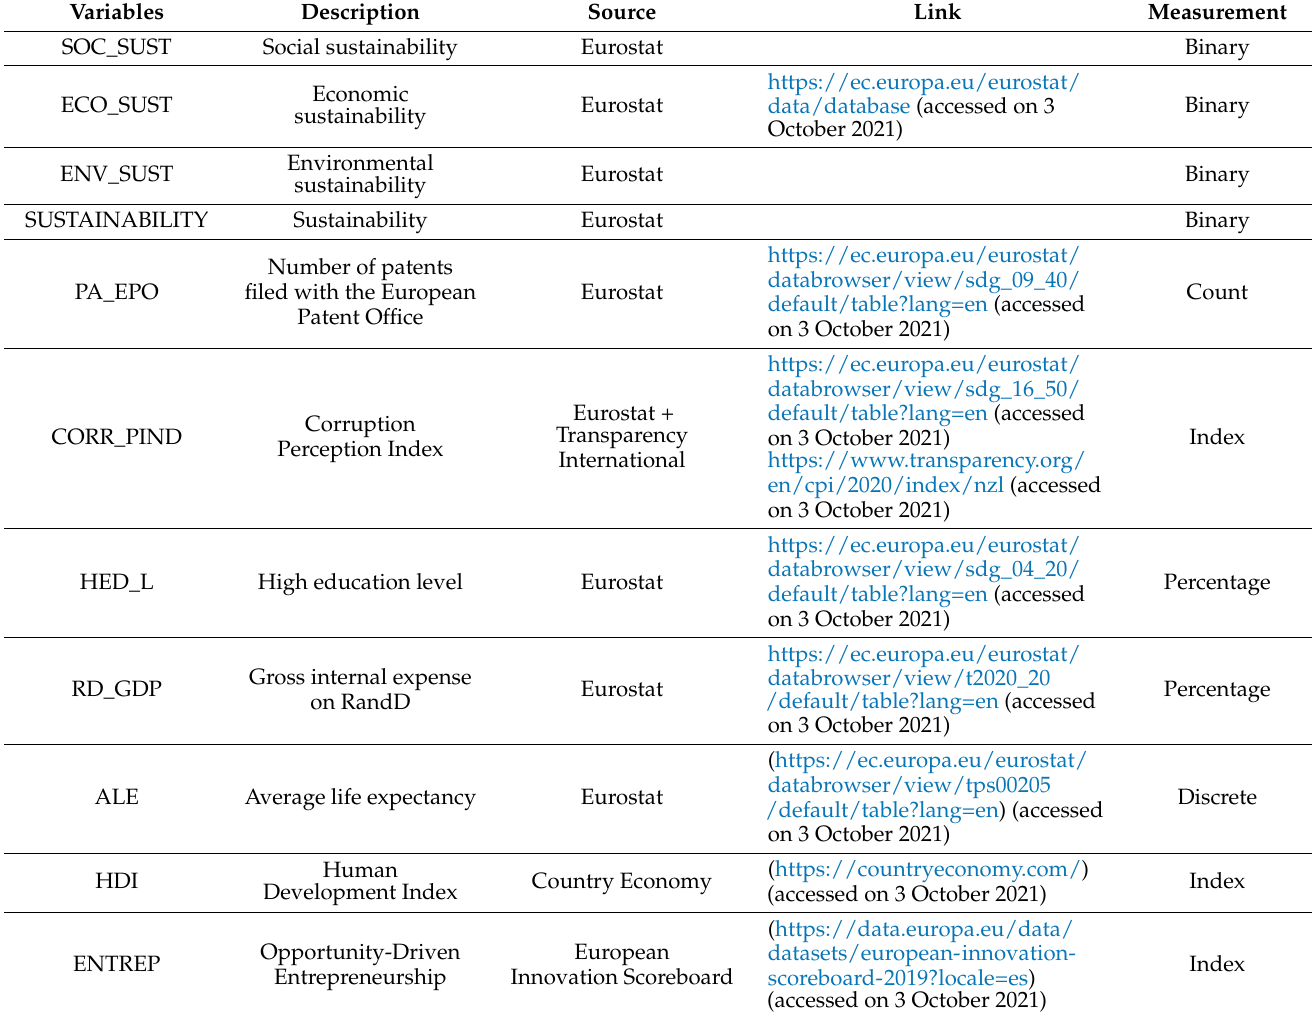
Table 3. Variable description, sources and